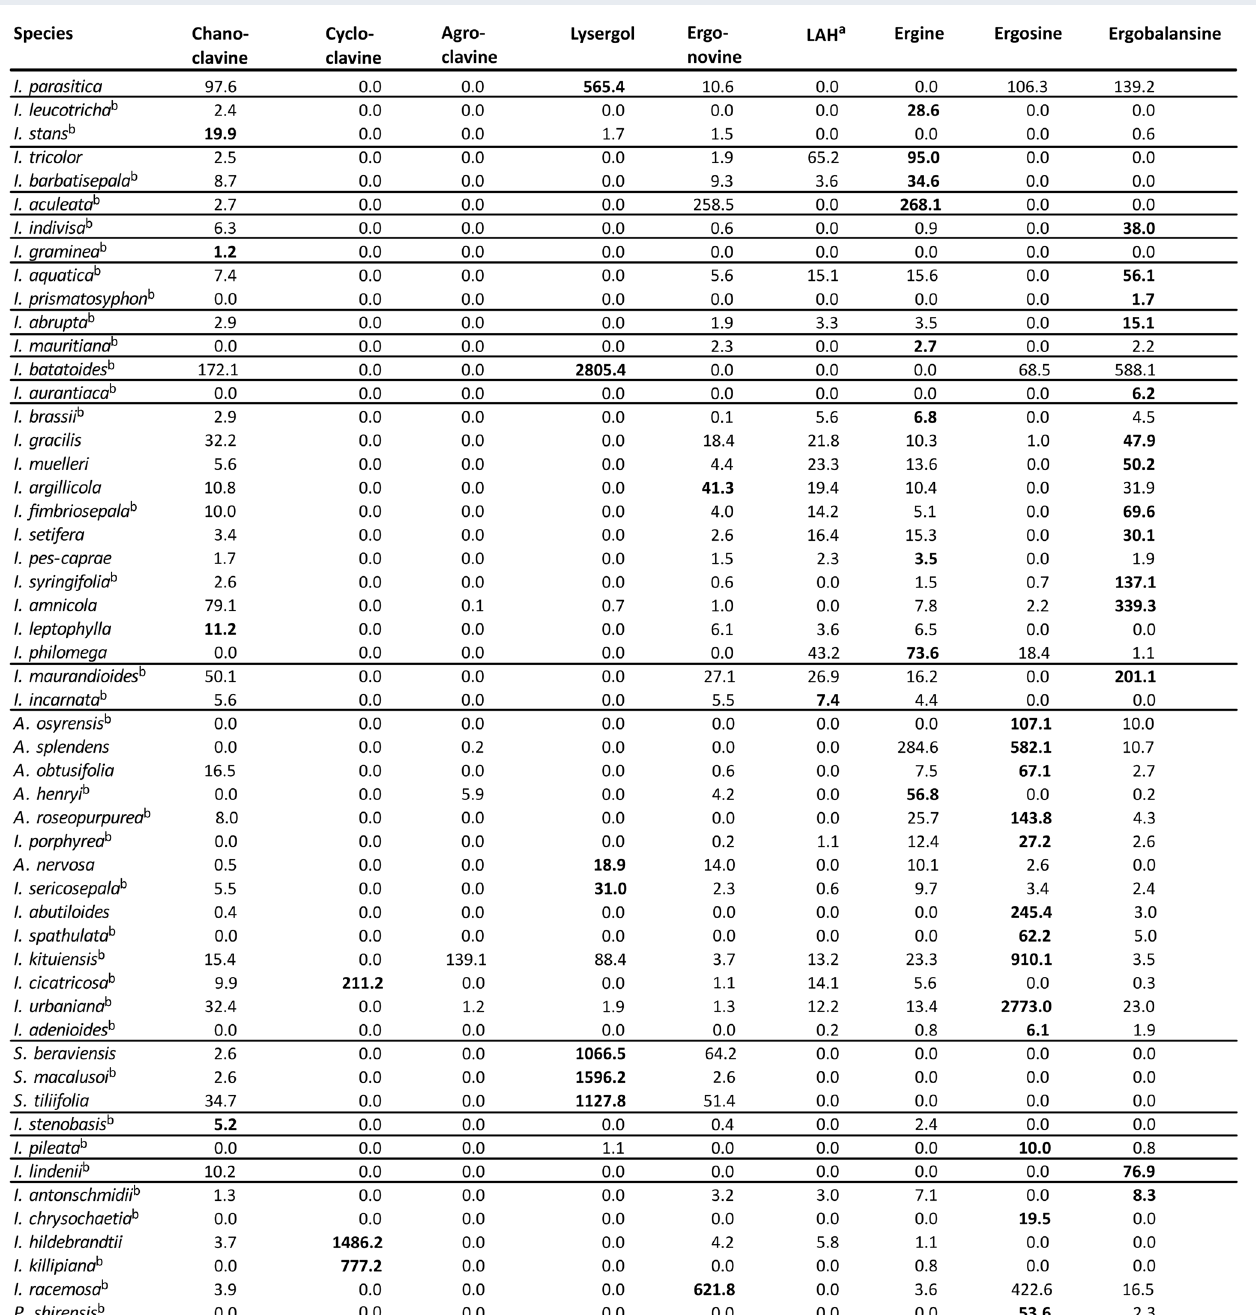
Table 1 EA-positive species and average alkaloid